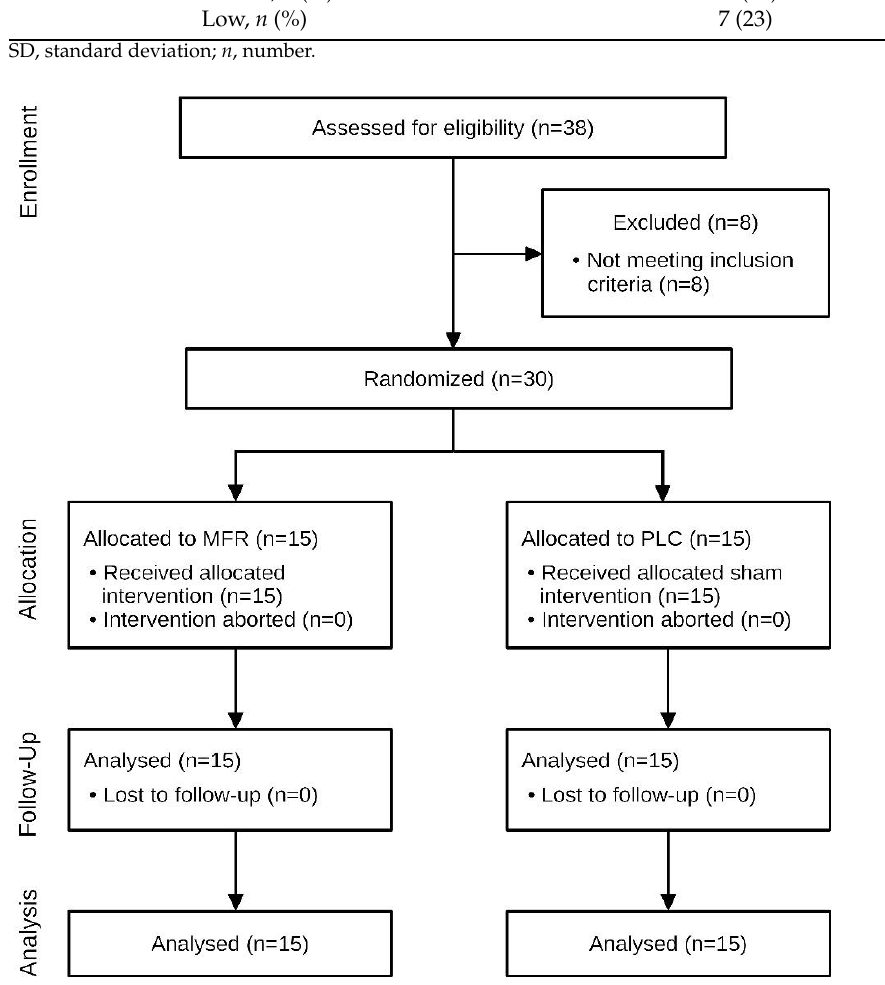
Figure 3. Flow diagram of the study. n , number; MFR, myofascial release; PLC, placebo.